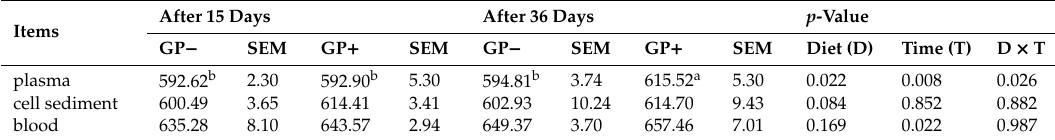
Table 4. Total polyphenols content in blood and its fractions (mg GAE / L